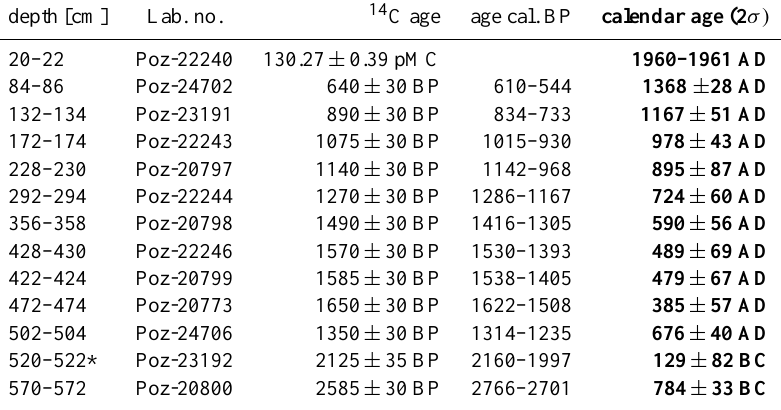
Table 1. Results of AMS radiocarbon dating: Sphagnum plant material is used for radiocarbon dating to avoid admixture of plant material relocated from the bog’s vicinity. In one case (*) plant fragments from Vaccinium spec. were used for 14 C dating, because Sphagnum plant material was not available in an adequate amount. The standard deviation for the calendar ages is given as 2 σ . The sample from a depth between 502 and 504 cm was omitted from the model, since its 14 C age is obviously too young. These results depict the radiocarbon dating of the upper approximately 5.5m of core DM-01 with a total length of ∼ 7.5m. The age depth model of the entire core is shown in Moschen et al. (2009) and K¨uhl et al. (2010). depth [cm] Lab. no. 14 C age age cal. BP calendar age (2